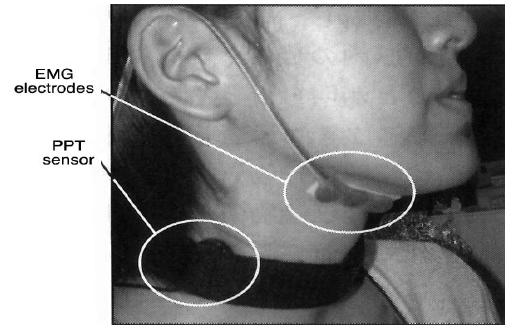
Figure 16. Piezo-Electric Pulse Transducer® and EMG electrodes mounted on the neck [59].